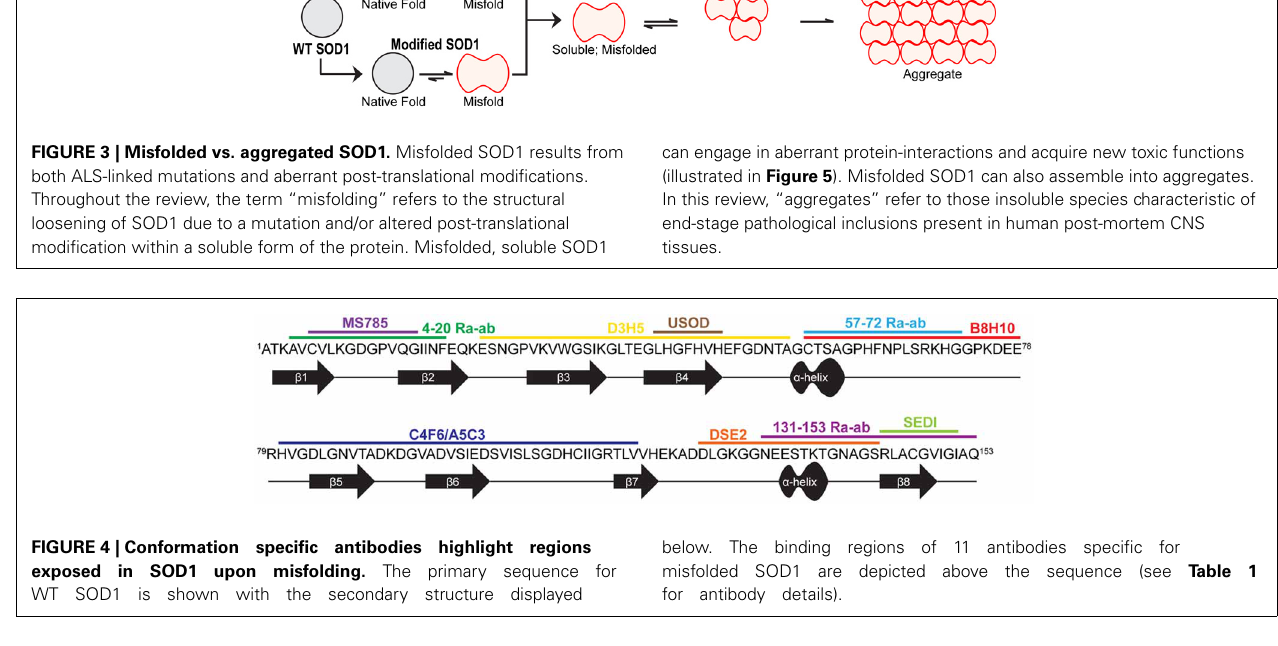
FIGURE 4 | Conformation specific antibodies highlight regions exposed in SOD1 upon misfolding. The primary sequence for WT SOD1 is shown with the secondary structure displayed